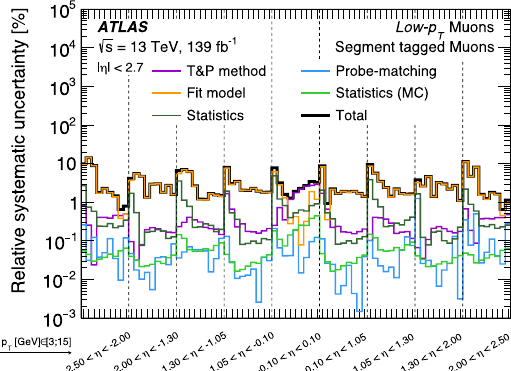
other kinematic observables. The resulting values are plotted as distinct measurements in each η bin with p T increasing from 3 to 15 GeV going from left to right. The total uncertainty is the sum in quadrature of all the individual